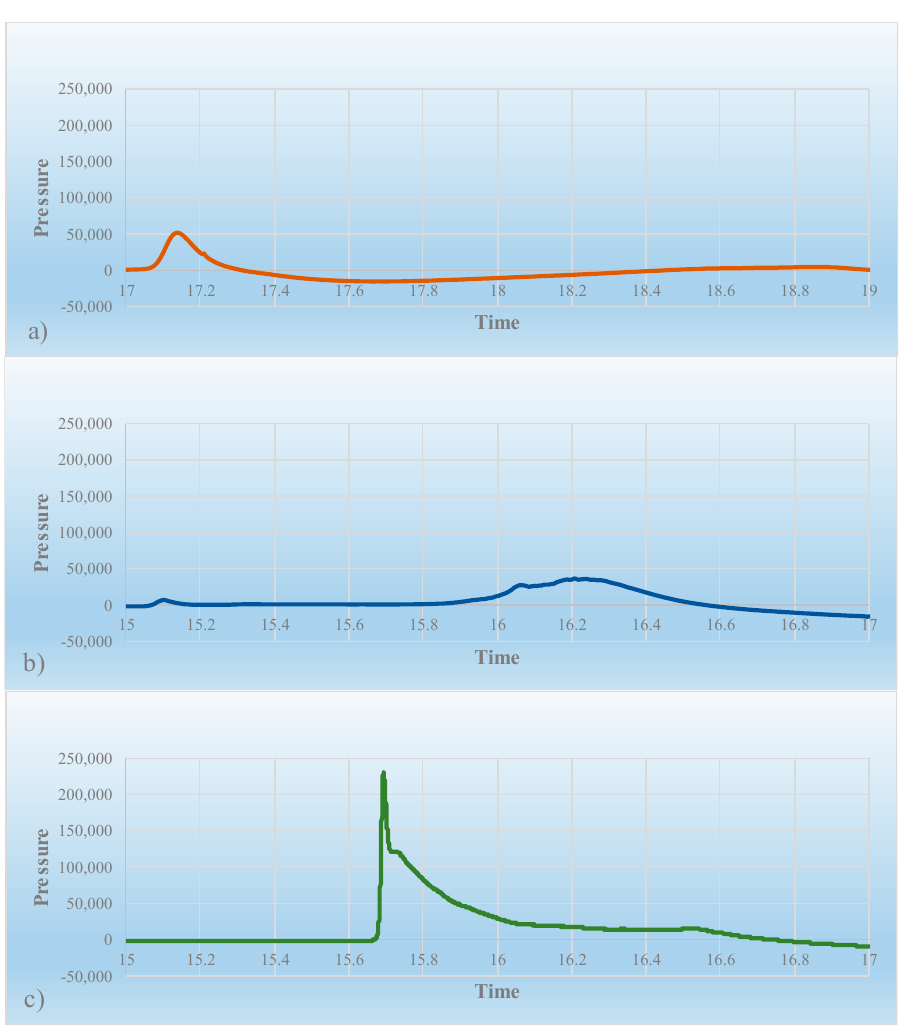
Figure 19. Comparison of pressure at the roof of the actual-size tank for different liquid depths, despite providing sufficient freeboard for all the cases based on the ACI code: ( a ) 10-m liquid depth; ( b ) 12-m liquid depth; and ( c ) 14-m liquid depth.